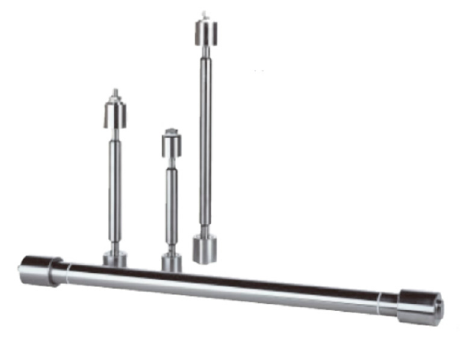
Figure 31. Radial push-pull transducer.